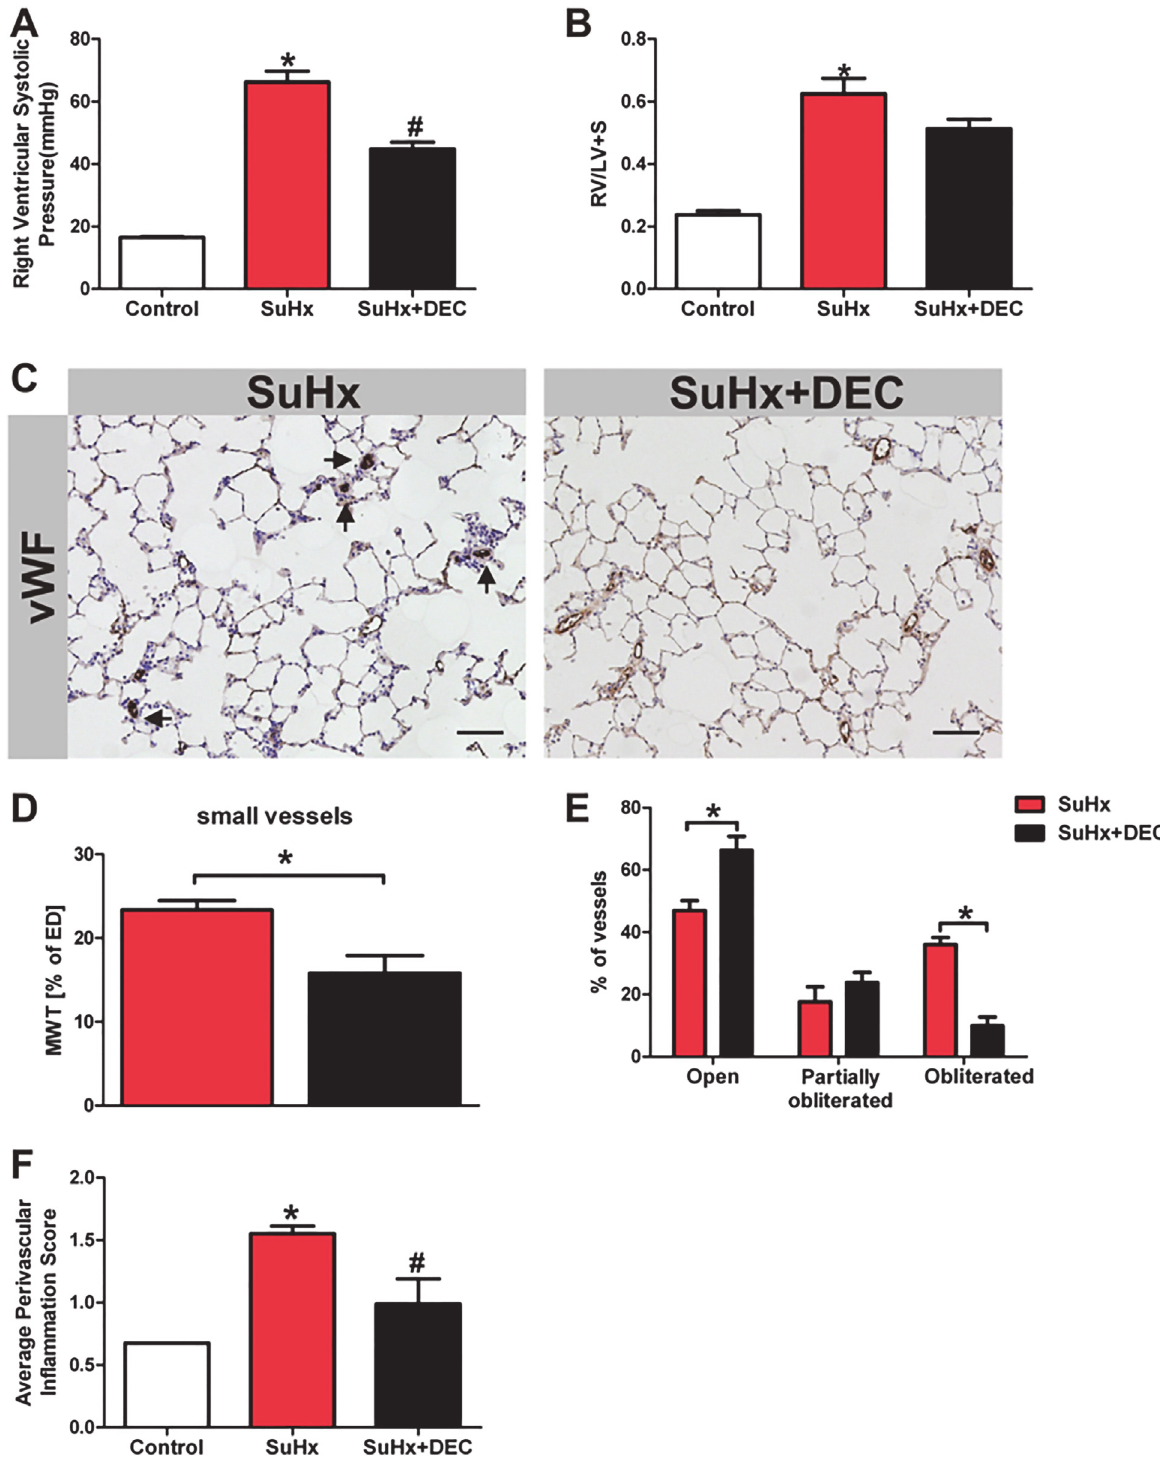
Fig 6. Diethylcarbamazine ameliorated pulmonary angioproliferation & the development of severe PAH. Measurement of the right ventricular systolic pressure (using a Millar catheter) shows a reduction in the RVSP in the SuHx rats following 3 weeks of treatment of the animals with diethylcarbamazine (DEC, 50 mg/kg) (A) (n = 6 – 8). While there is a reduction of the RVSP in the DEC treated animals there is a trend to reduction in the right ventricular hypertrophy but it did not reach a statistical significance(RV/LV+S) (B) (n = 6 – 8). (C) Scale bar = 100 μ m. There is a significant reduction of angioobliteration and muscularization in the lungs from rats treated with DEC (D, E) (n = 6 – 8). Panel (F) shows that DEC treatment reduced the degree of perivascular cell accumulation (n = 6 – 8). MWT = media wall thickness, ED = external diameter. * P < 0.05 vs. control, #P < 0.05 vs. SuHx. vWF = von Willebrand factor doi:10.1371/journal.pone.0120157.g006 PLOS ONE | DOI:10.1371/journal.pone.0120157 March 18,